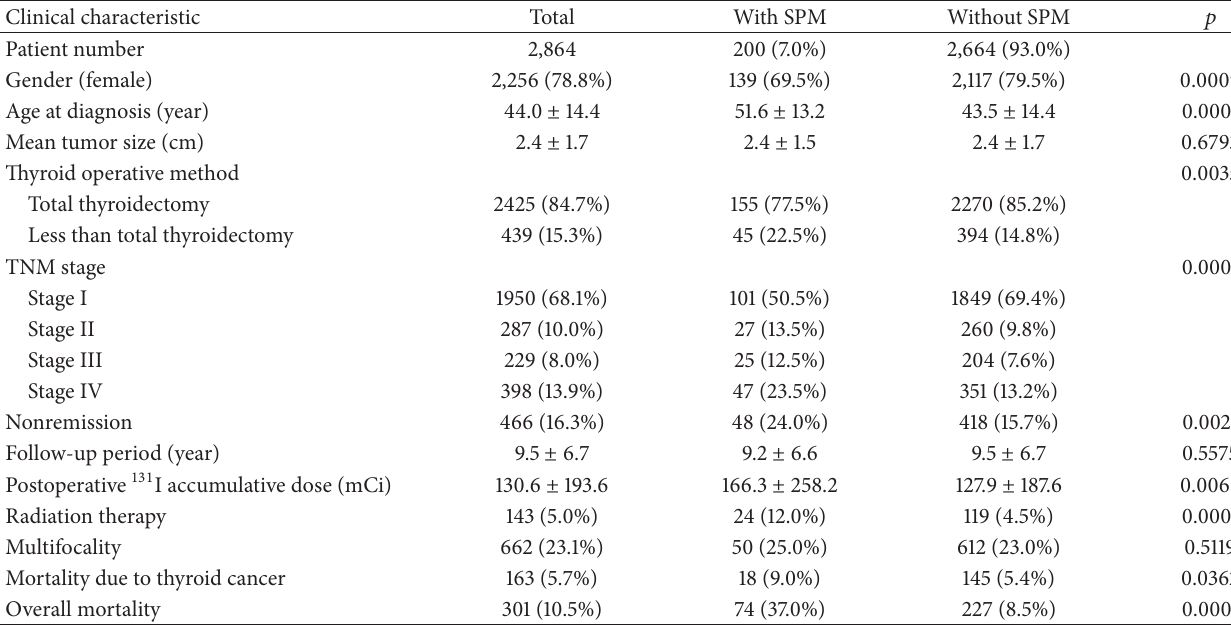
Table 1: Clinical features of 2,864 cases of well-differentiated ∗ thyroid cancer with or without second primary malignancies (SPMs) between 1984 and 2013.